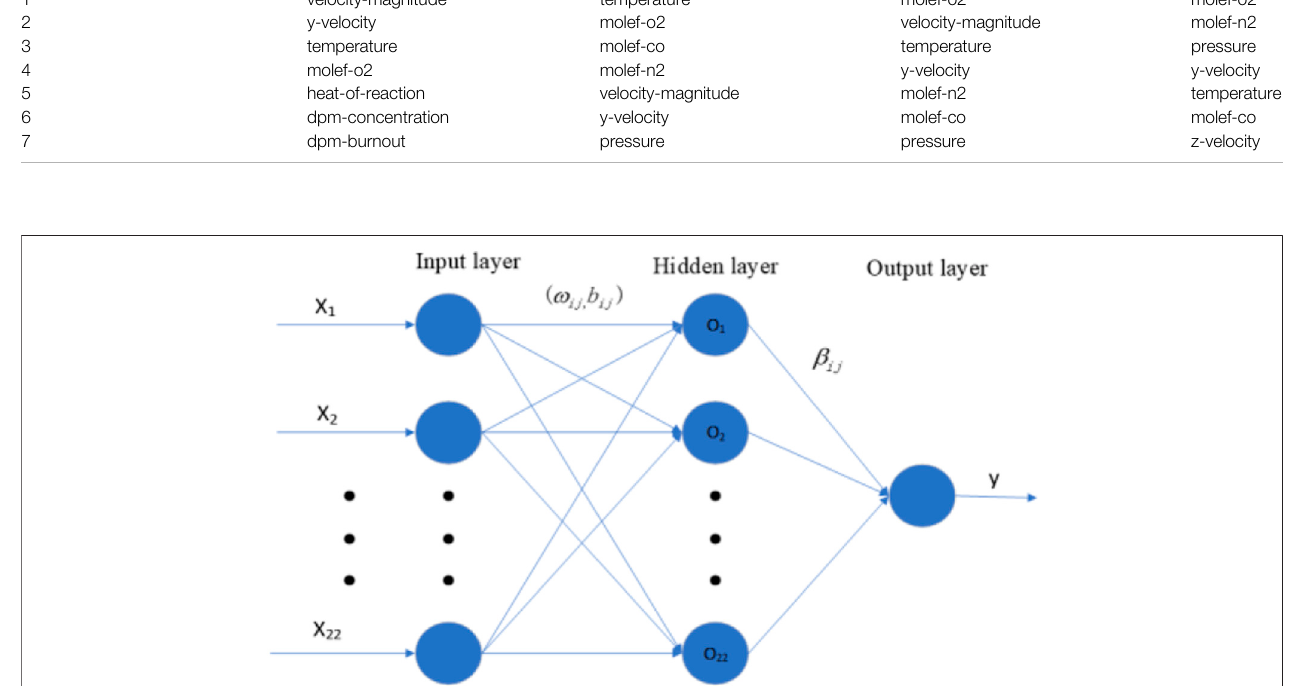
FIGURE 4 | Structural diagram of the ELM network.